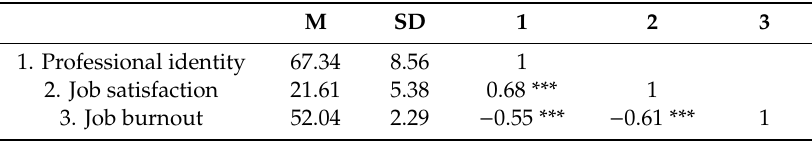
Table 1. Descriptive statistics and correlation analysis matrix.